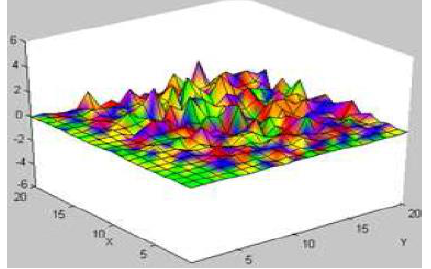
Figure 2: 3D representation of a multi-scale surface using Daubechies wavelet with multi-scale parameters ( 𝛎 𝟏 =1.3;